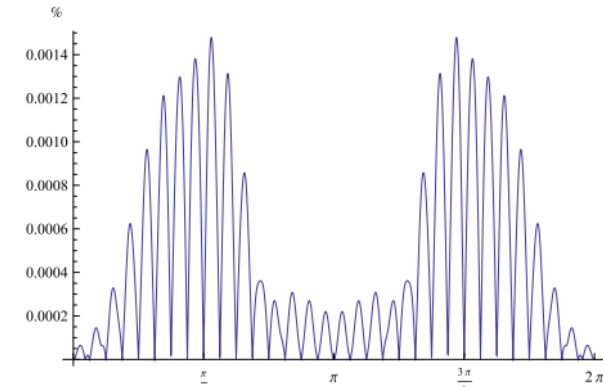
Figure 4: Conditioning Number vs Genetic algorithm The error calculated for this structure, when considering the values obtained with the combinaison MAS/GA, is given by figure 5. It shows a good convergence of the solution.